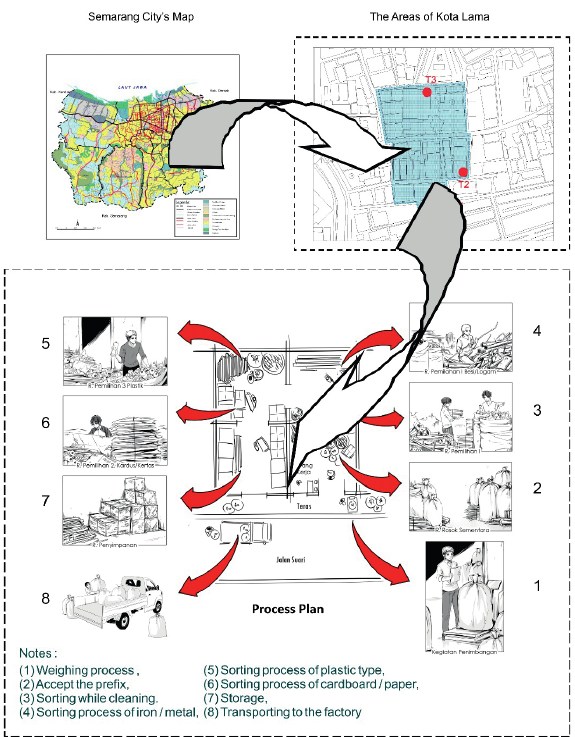
Fig. 5. The Space Layout for Informal Sector Activities Fig. 6. Responsibility